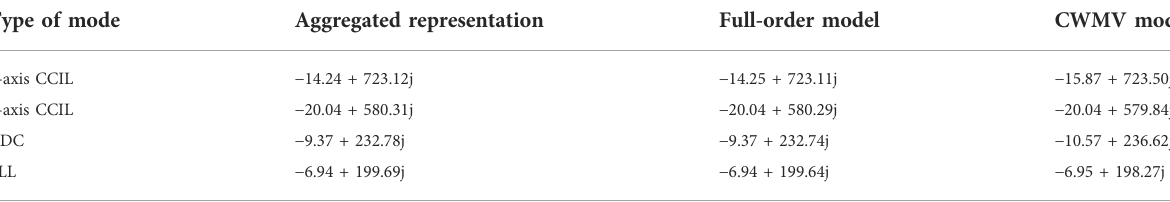
TABLE 1 Oscillation modes of the cluster of fi ve inverters in daisy-chain connection (case study